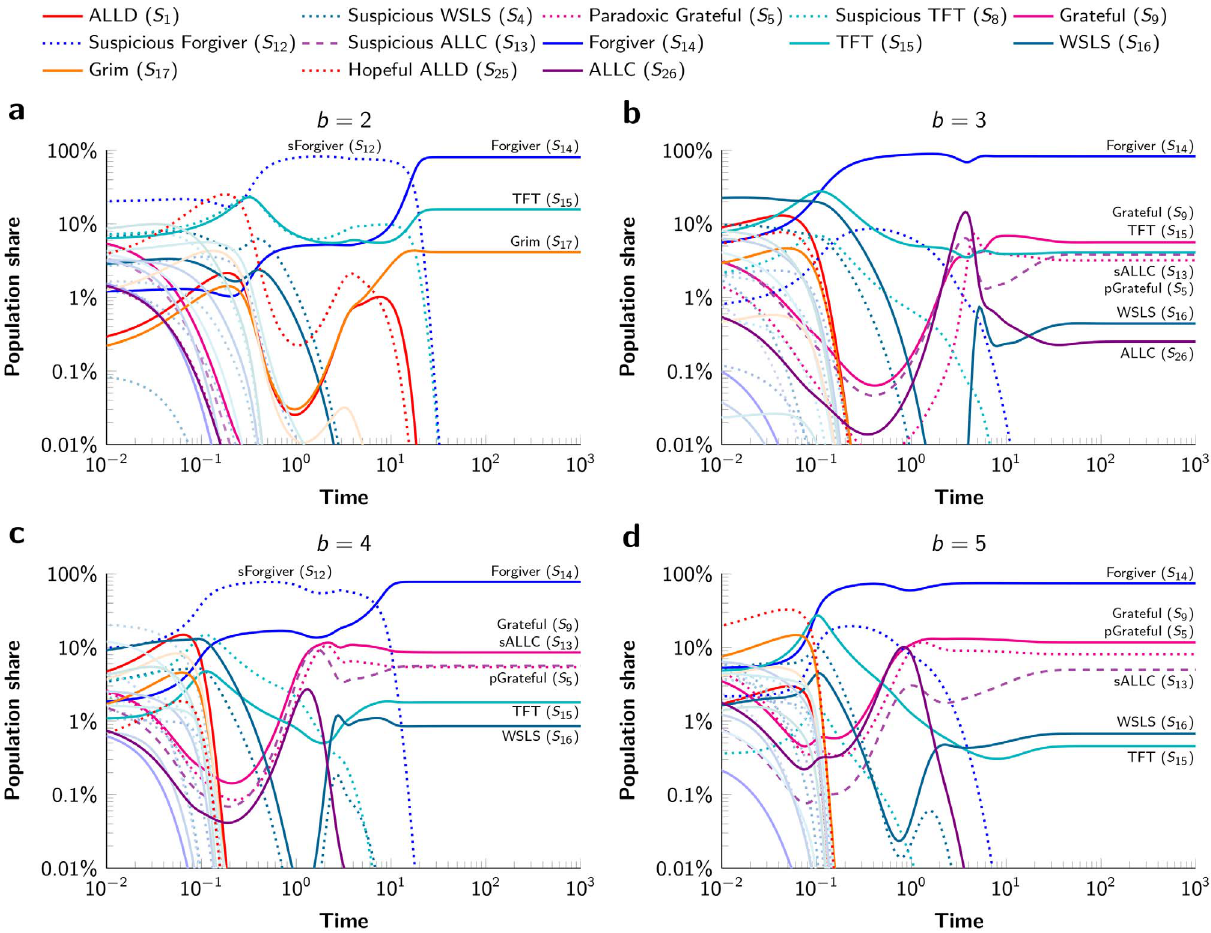
Figure 3. The evolution of strategies in the alternating Prisoner’s Dilemma. In all panels, the simulations start from a randomly chosensome random point in the 26 -simplex. In the cases of b ~ 3 , b ~ 4 , and b ~ 5 , the evolutionary trajectories converge to a cooperative alliance of many strategies dominated by the strategy Forgiver. In the case of b ~ 2 , the evolutionary trajectories converge to a mixed equilibrium of Forgiver, TFT, and Grim. The error rate E is set to 5 %, the number of rounds per game is L ~ 100 , and the mutation rate is u ~ 0